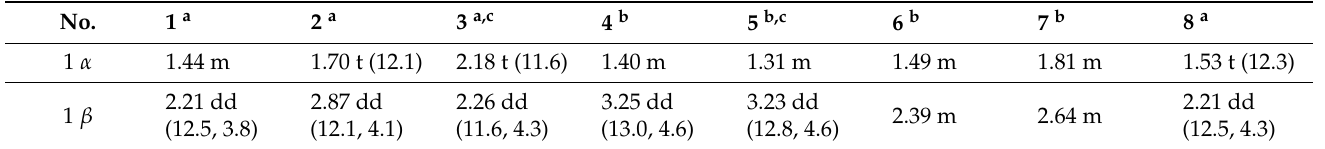
Figure 2. Key COSY (–), HMBC ( → ), and NOESY (H ↔ H) correlations of pholiol L ( 1 ). Compound 2 (pholiol M) was obtained as a colorless amorphous solid with an optical rotation of [ α ] 23 D − 10.9 ( c 0.05, CHCl 3 ). Its molecular formula was assigned as C 39 H 60 O 11 by the deprotonated molecular ion at m / z 703.4078 [M-H] − (calcd for C 39 H 59 O 11 − 703.4063) in HRESIMS. The 1 H NMR and 13 C-JMOD spectrum showed that compound 2 is a lanostane diester esterified with an acetic acid [ δ H 2.07 s (3H); δ C 170.84 (CO), 21.07 (CH 3 )], and a 3-hydroxy-3-methylglutaryl 6-methyl ester [ δ H 2.68 m, 2.54 m (H 2 -2 (cid:48) ), 2.70 m, 2.62 m (H 2 -5 (cid:48) ), 1.35 s (H 3 -4 (cid:48) ), 3.71 s (OCH 3 -7 (cid:48) ); δ C 171.44 (1 (cid:48) ), 172.28 (C-6 (cid:48) ), 44.99 (C-2 (cid:48) ), 45.04 (C-5 (cid:48) ), 69.72 (C-3 (cid:48) ), 27.70 (C-4 (cid:48) ), 51.94 (OCH 3 -7 (cid:48) )] (Tables 1 and 2). Similarly to pholiol L ( 1 ), compound 2 contained the 8,9-en-7-one moiety [ δ C 139.69 (C-8), 160.48 (C-9), 199.71 (C-7)] and C 8 aliphatic chain at C-17 substituted with a keto [ δ C 214.92 (C-24)] and a hydroxy group [ δ C 76.38 (C-25)]. The 1 H NMR and JMOD spectra exhibited an additional O -substituted methine at δ H 4.57 br t (5.7 Hz), δ C 67.31, which was placed at C-11 with regard to the 1 H- 1 H COSY [ δ H 2.28 m, 1.88 m, 4.57 br t; –CH 2 –CH(OH)–; C-12–C-11] and HMBC correlations of H-11 with C-8 and C-13; and H-12 with C-14. The assignment of C-11 ( δ C 67.31) and C-12 ( δ C 42.90) were in agreement with literature data [13]. The 1 H- 1 H COSY spectrum defined the structural fragment with correlated protons –CH 2 –CH(OR)–CH(OR)– ( δ H 2.87 dd, 1.70 t, 5.29 dt, and 4.83 d) (C-1–C-3). The positions of the ester groups were established via the HMBC experiment. The correlations of the carbonyl signals at δ C 171.44 (1 (cid:48) ) and 170.84 (AcCO) with the proton signals at δ H 5.29 (H-2) and δ H 4.83 (H-3) indicated the presence of the MeHMG and acetyl groups at C-2 and C-3, respectively. The relative configuration was determined with the use of a NOESY measurement. The Overhauser effects between H-5/H-3, H-3/H 3 -28, H-3/H-1 α , and H-1 α /H-11 pointed these protons in the α position, while those between H-1 β /H-2, H-2/H 3 -19, H 3 -19/H-1 β , and H-2/H 3 -29 indicated their β position. The above findings were consistent with the proposed structure of 1 , as depicted in Figure 1. Table 1. 1 H NMR data of pholiols L–Q ( 1 – 8 ) [(500 MHz, δ ppm ( J = Hz)].